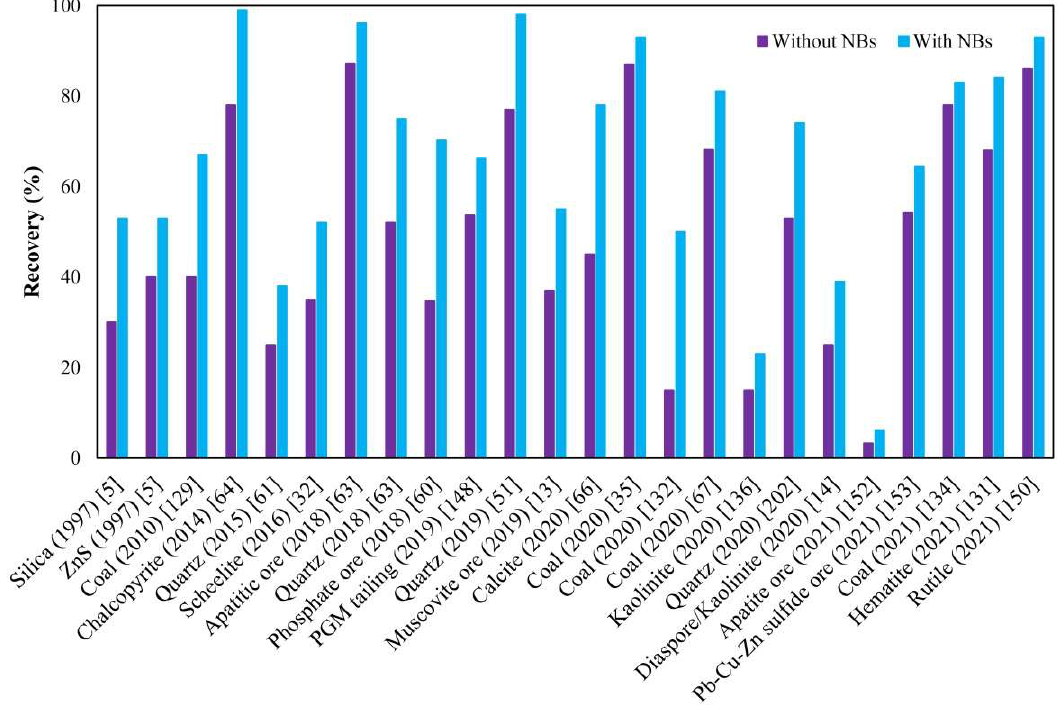
Figure 10. Studies conducted on NBs-assisted flotation in mechanically agitated flotation cells in 1997–2021 [5,13,14,32,35,51,60,61,63,64,66,67,131,133–136,148,150,153,154,201].